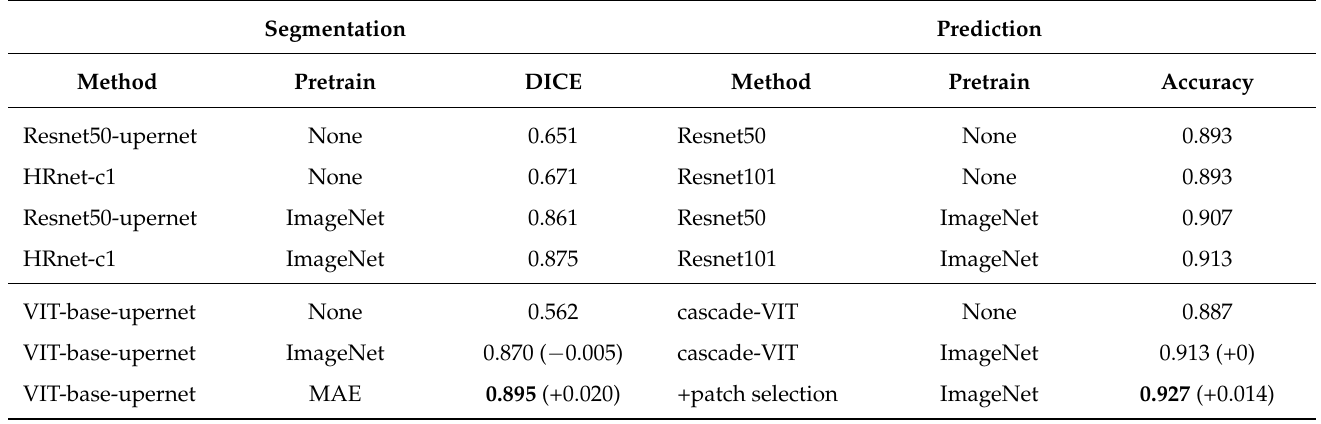
Figure 2. Segmentation and cropping results of proposed modules. We showed three examples in this figure. The first column, original intensity images; the second column, manual annotations; the third column, automatic segmentations; the fourth column, original blood-perfusion images; the final column, the cropped blood-perfusion images. The first row showed the keloid in the progressive stage; the middle row showed the keloid in the stable stage; the last row showed the keloid in the regressive stage. Table 2. Ablation